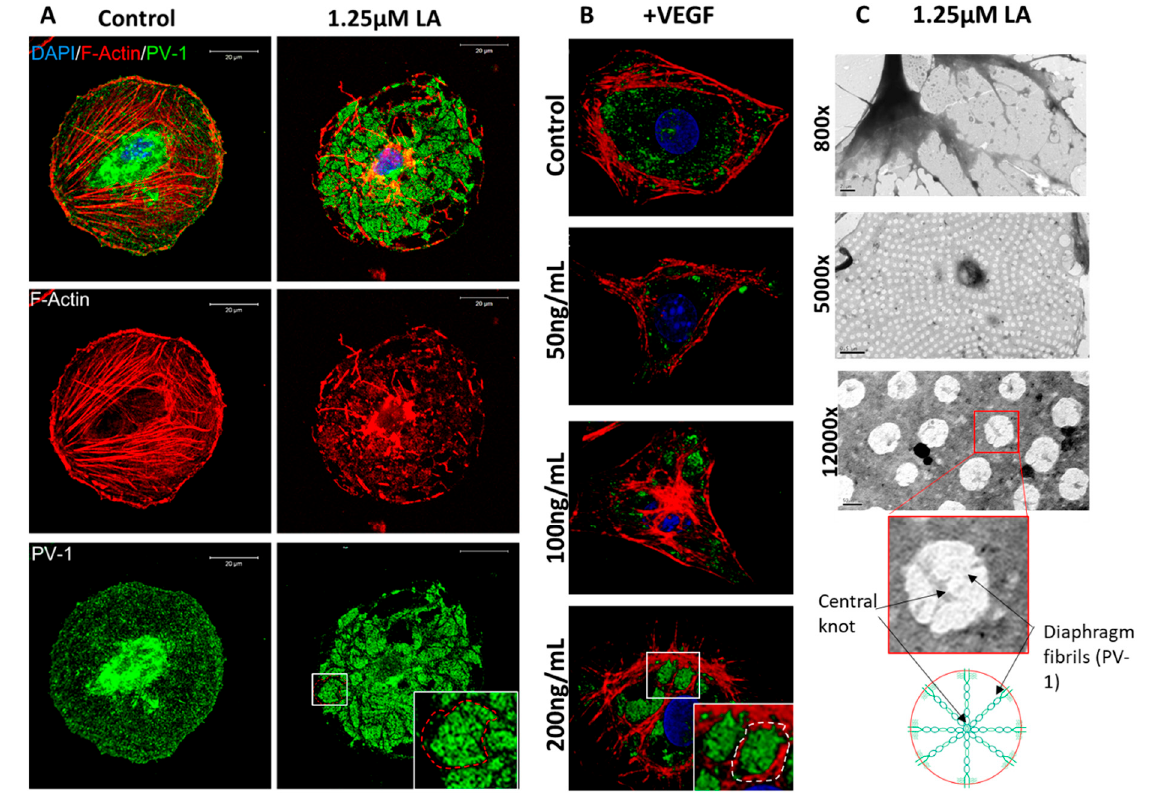
Figure 1. bEND.5 cells have the potential to become fenestrated. ( A ). BEND.5 cells treated with 1.25 µ M of LA had PV-1 (green) and actin (red) redistribution to sieve plates as compared to control non-treated cells (sieve plate indicated by white box and red dotted line). ( B ). VEGF-induced sieve plate formation could also be stimulated in bEND.5 cells as illustrated by the rearrangement of PV-1 (green) and the actin cytoskeleton (red) (white box and dotted line indicate sieve plate formation in 200 ng/mL of VEGF-treated bEND.5 cells). ( C ). TEM showed uniform distribution of fenestrae (800 × magnification, scale bar: 1 µ M; 5000 × magnification, scale bar: 0.5 µ M). At high magnification, fenestrae diaphragm fibrils and central knots could be visualized (12,000× magnification, scale bar: 200 nm) as highlighted in the accompanying diagram.